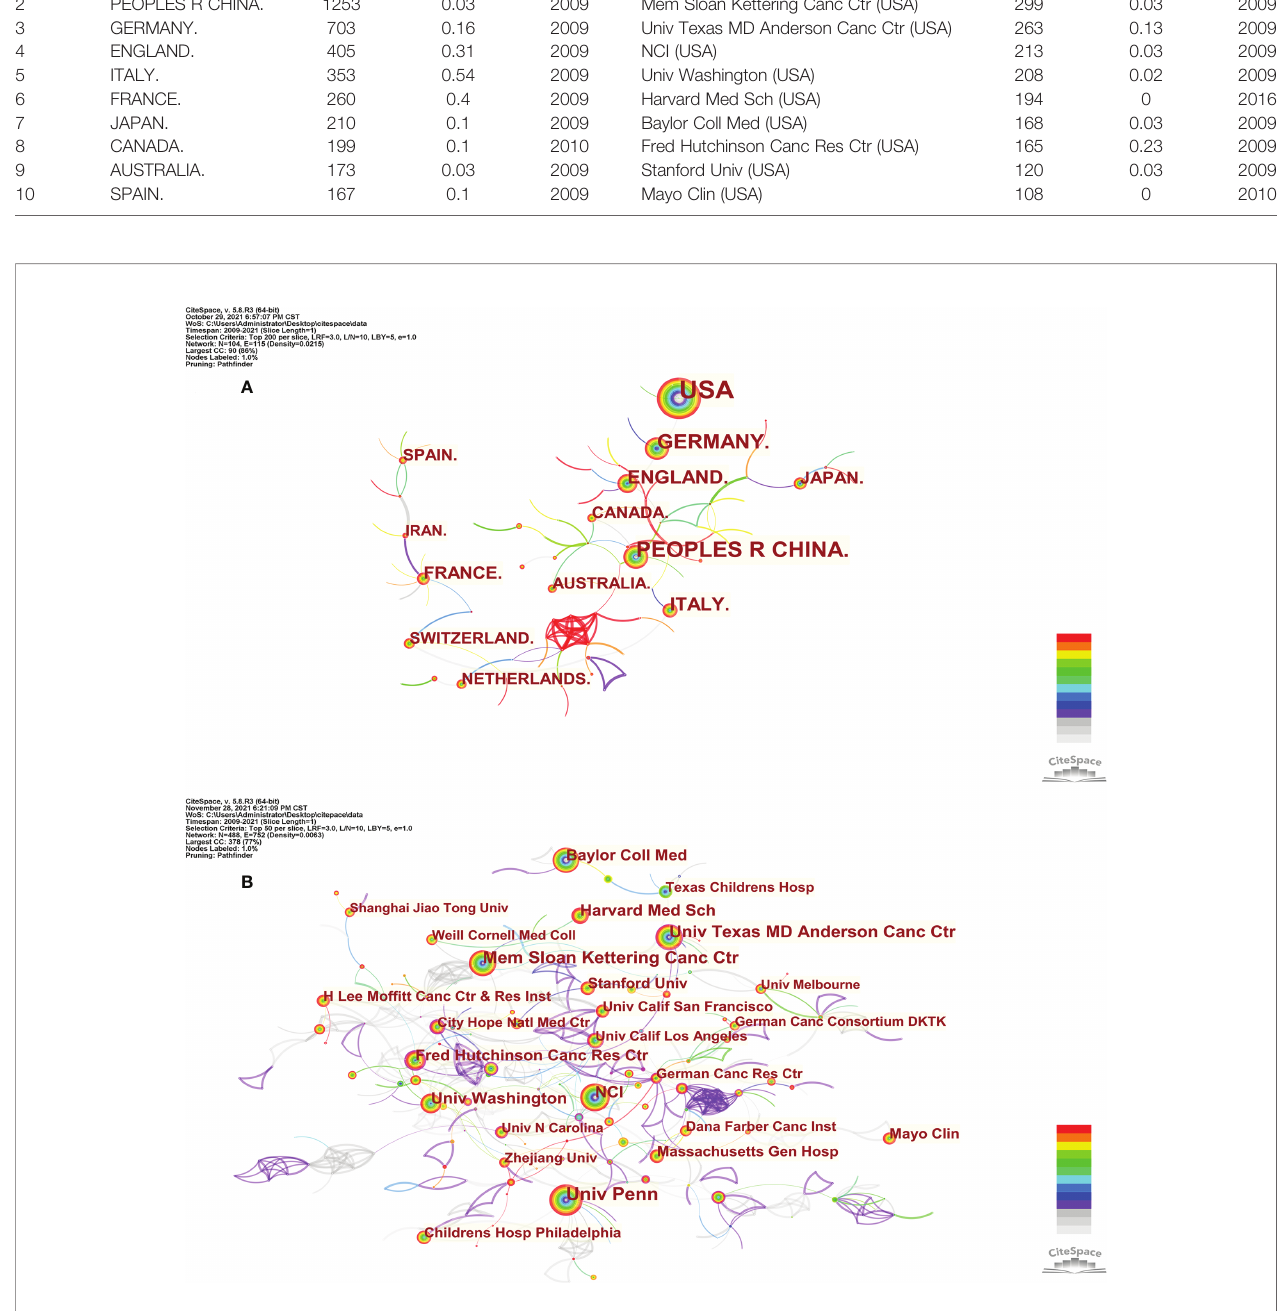
FIGURE 2 | The co-occurrence map of countries/regions (A) and institutions (B) in CAR-T cell